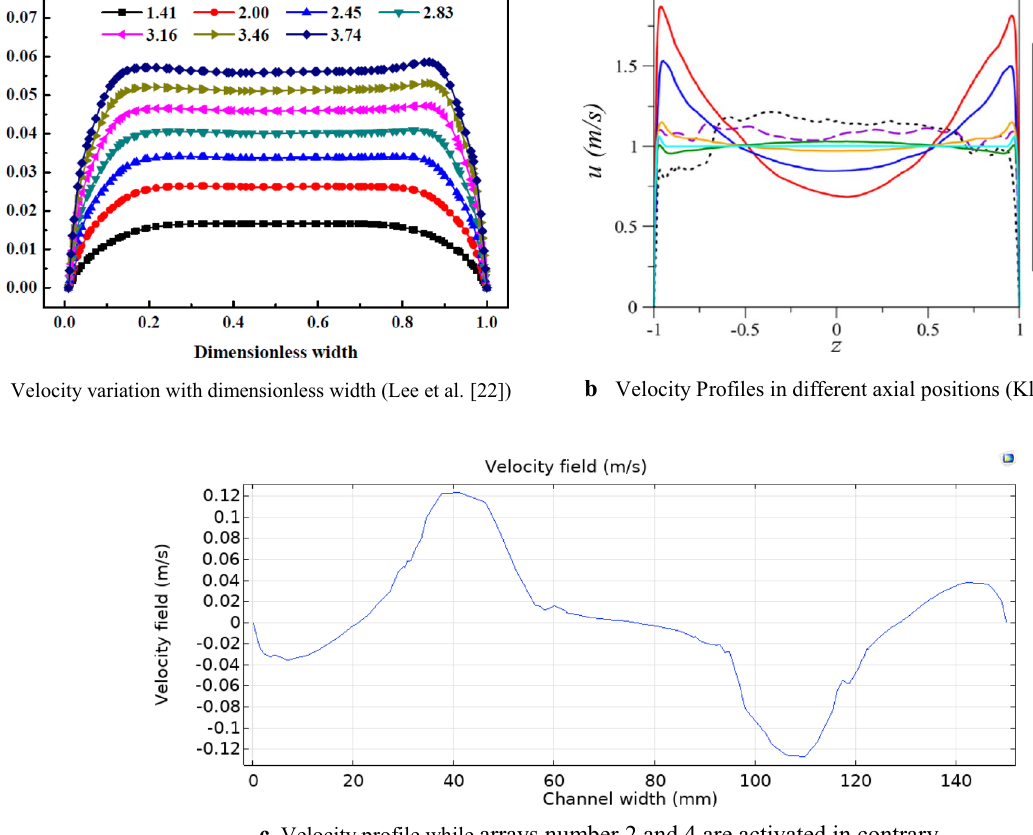
Fig. 21 Comparison of velocity profiles in other works to those in the present